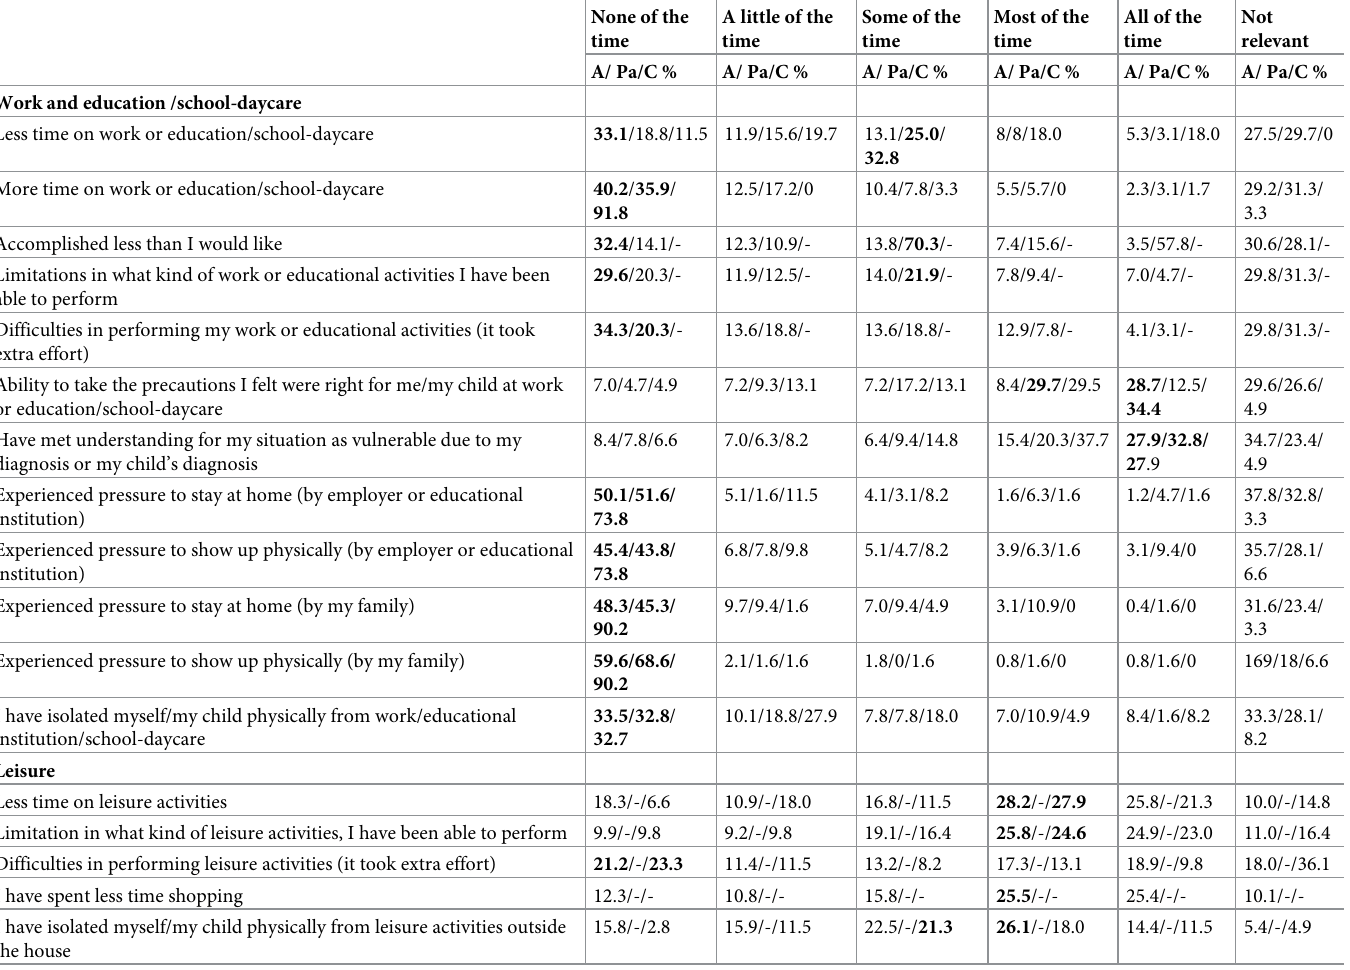
Table 5. Perceptions of how COVID-19 has influenced work/education, school, day-care and leisure